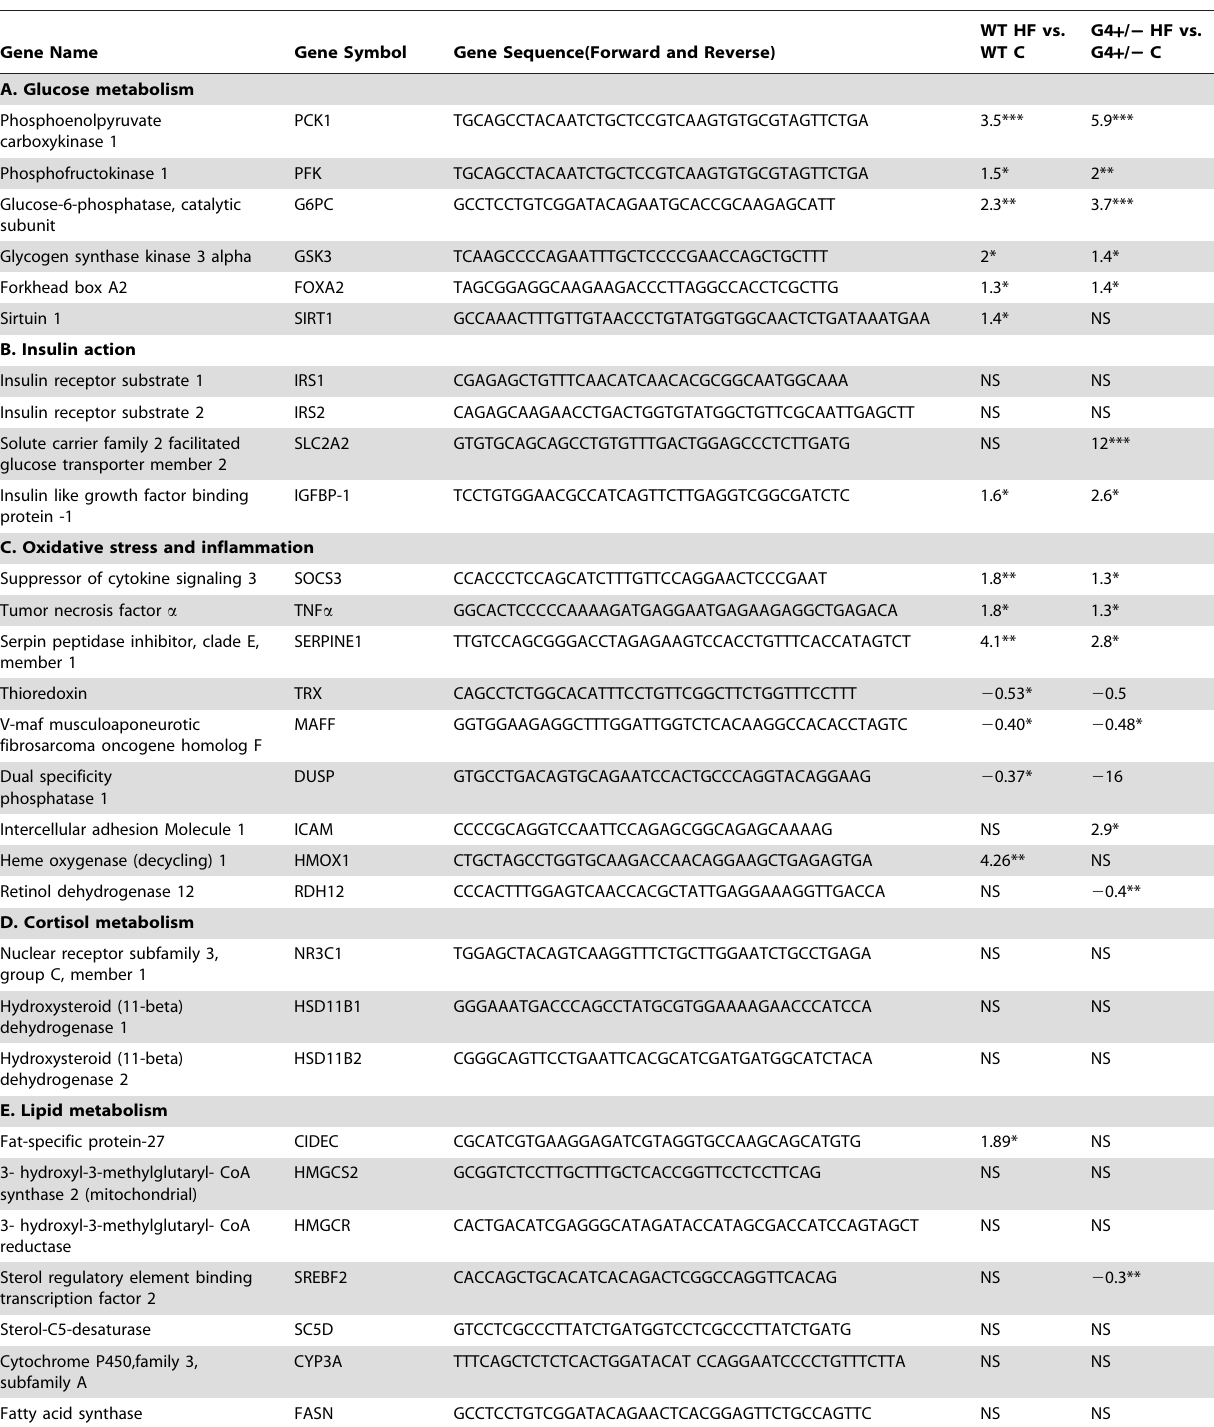
Table 3. Relative Hepatic mRNA Expression in WT and G4 + / 2 fetuses exposed to HF IU Compared to C